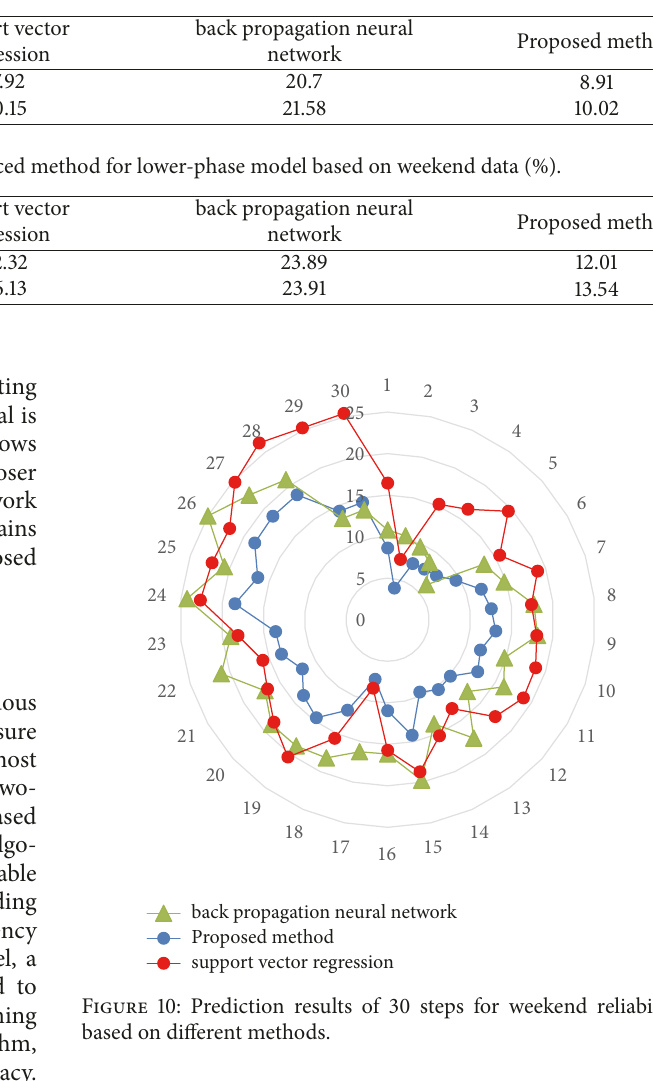
Table 3: MAPE of proposed method and referenced method for lower-phase model based on weekday data (%).